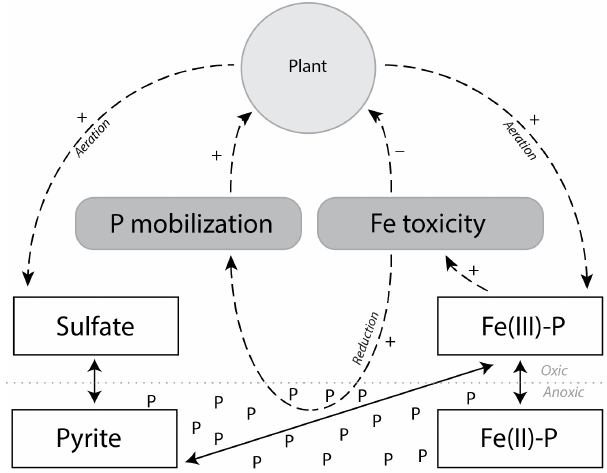
Figure 6. Most important biogeochemical processes and feedbacks identified in this study. + indicates positive feedback; − indicates negative